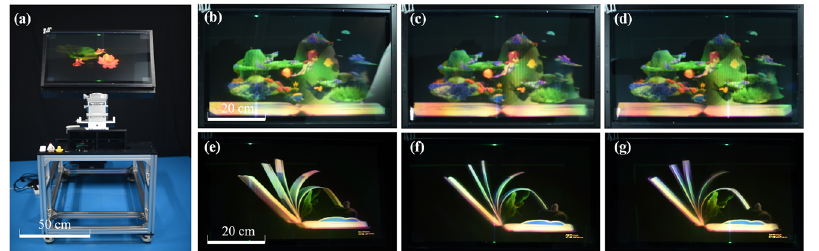
Figure 4: (a) The prototype of a glasses-free augmented reality 3D display. (b – d) Pro- jected 3D images of a mermaid observed from left, middle, and right view. (e – g) Projected 3D images of a book observed from left, middle, and right view in dark room.